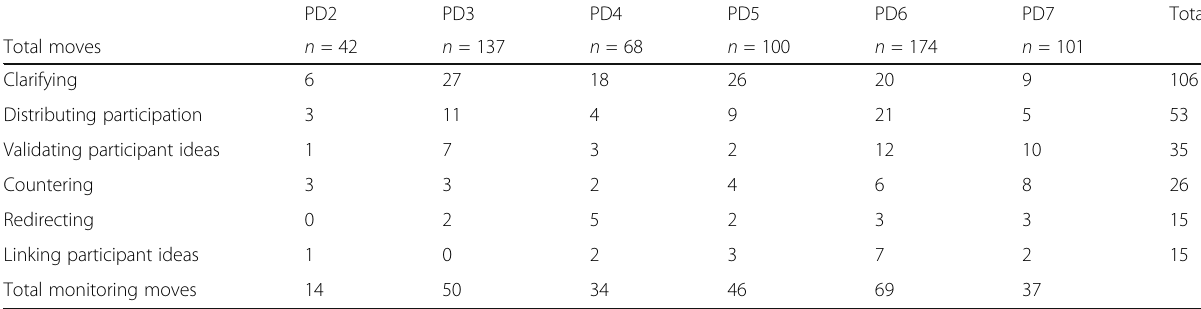
Table 3 Frequency of monitoring moves across the TSCD-PD sessions